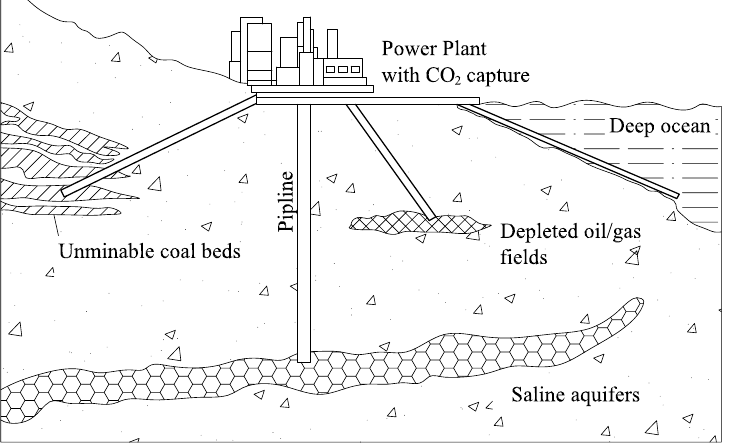
diffusion techno-paradigm. 2